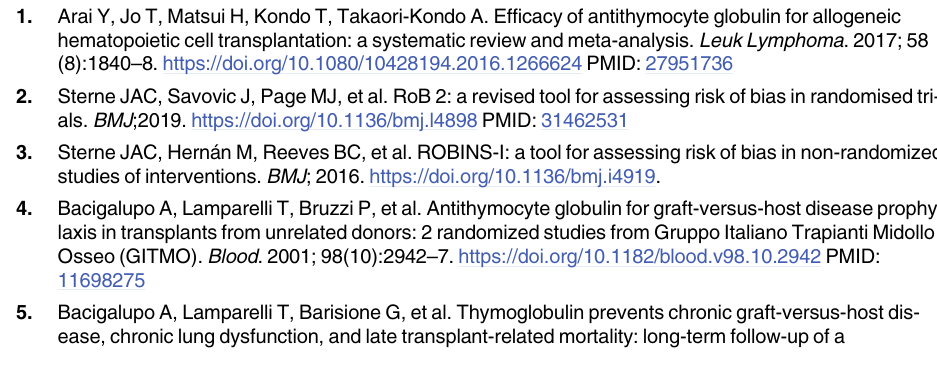
S4 Fig. Sensitivity analysis per type of transplantation. (DOCX) S5 Fig. Sensitivity analysis for CMV and EBV, and recurrence. S6 Fig. Sensitivity analysis per first ATG–T infusion day. S1 Table. Search methods and number of studies